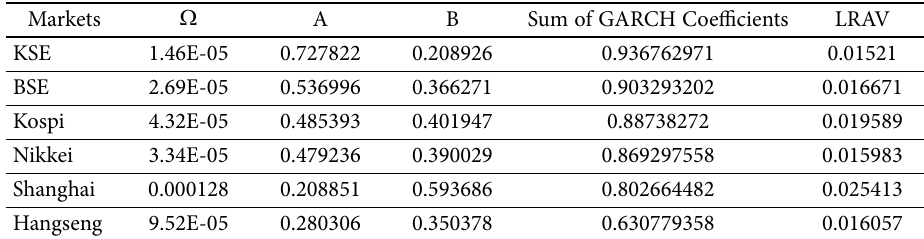
Table 6. Econometric analysis (GARCH Coefficients)